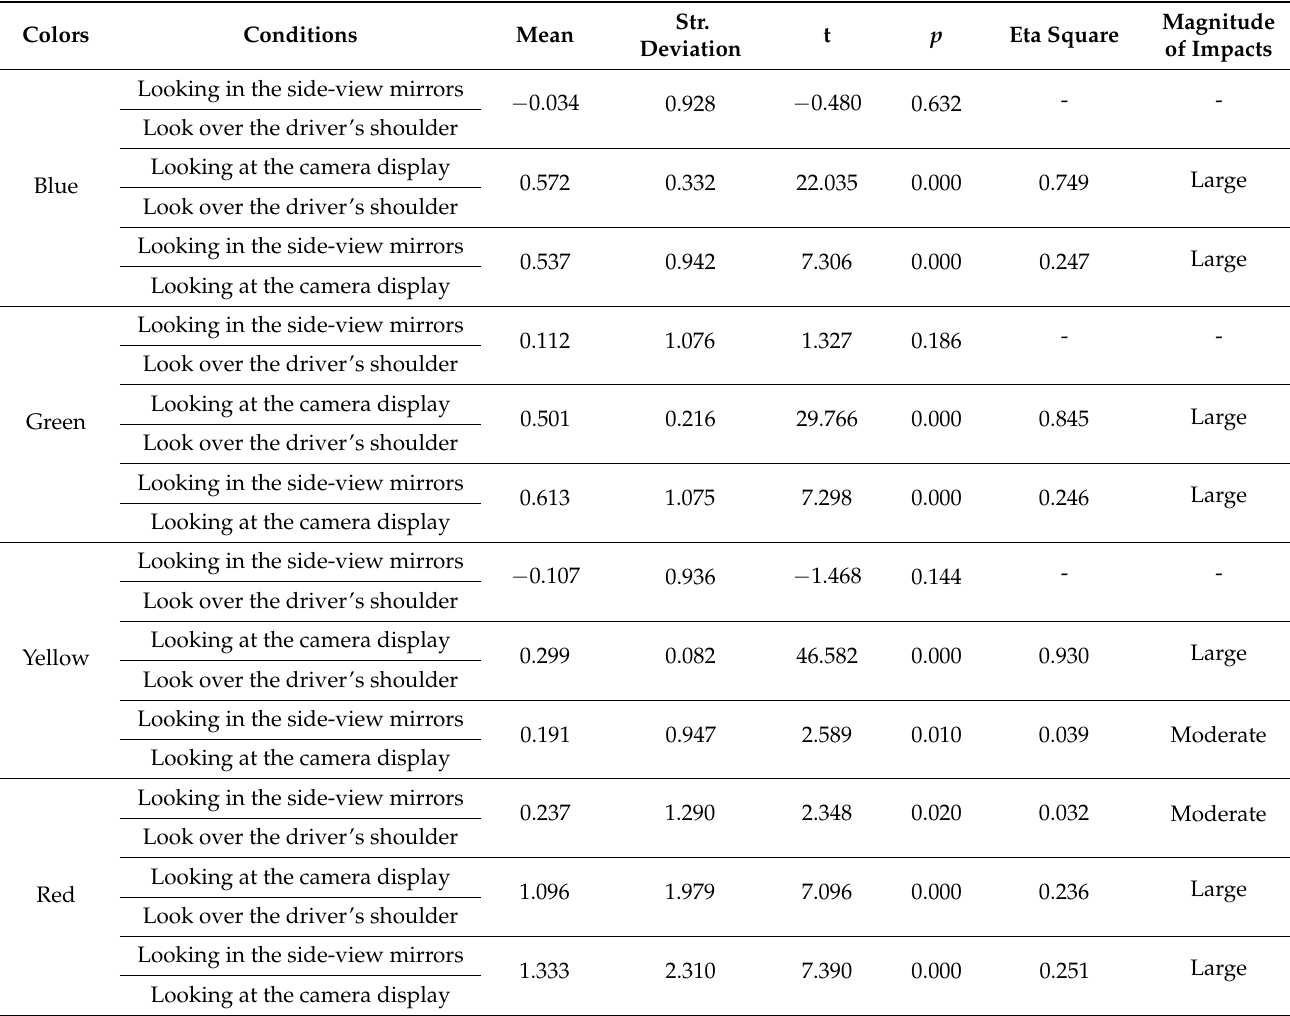
Table 3. Differences in the estimation of the distance to the object for all conditions and all